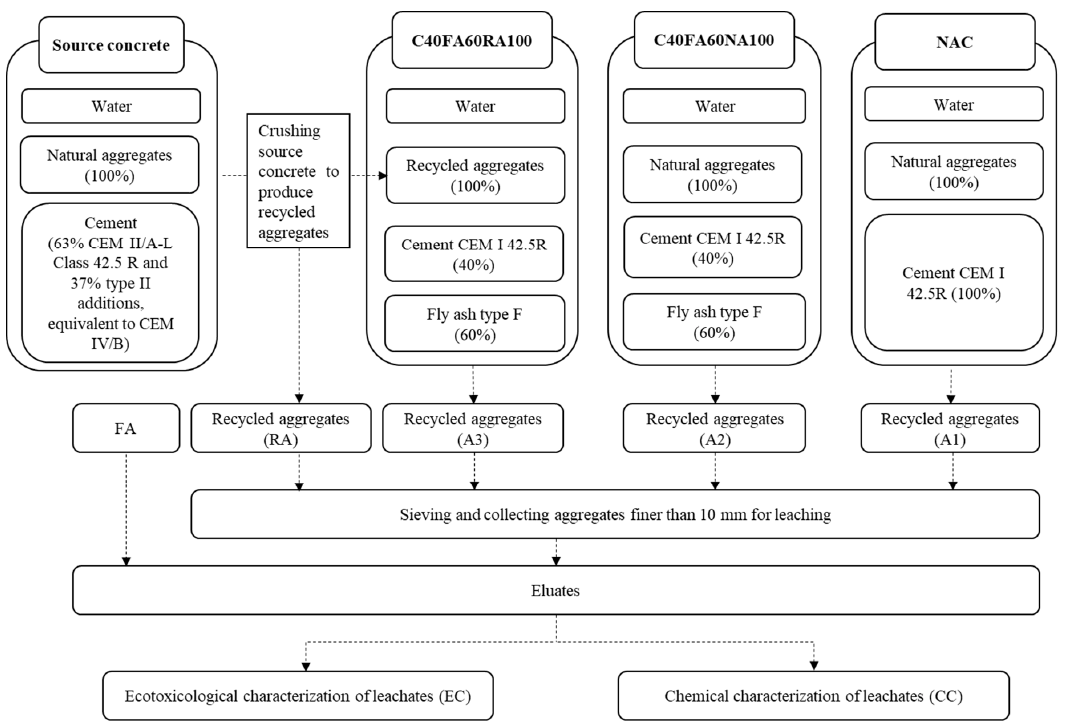
Figure 1. Flowchart of the methodology to perform chemical and ecotoxicological characterizations.